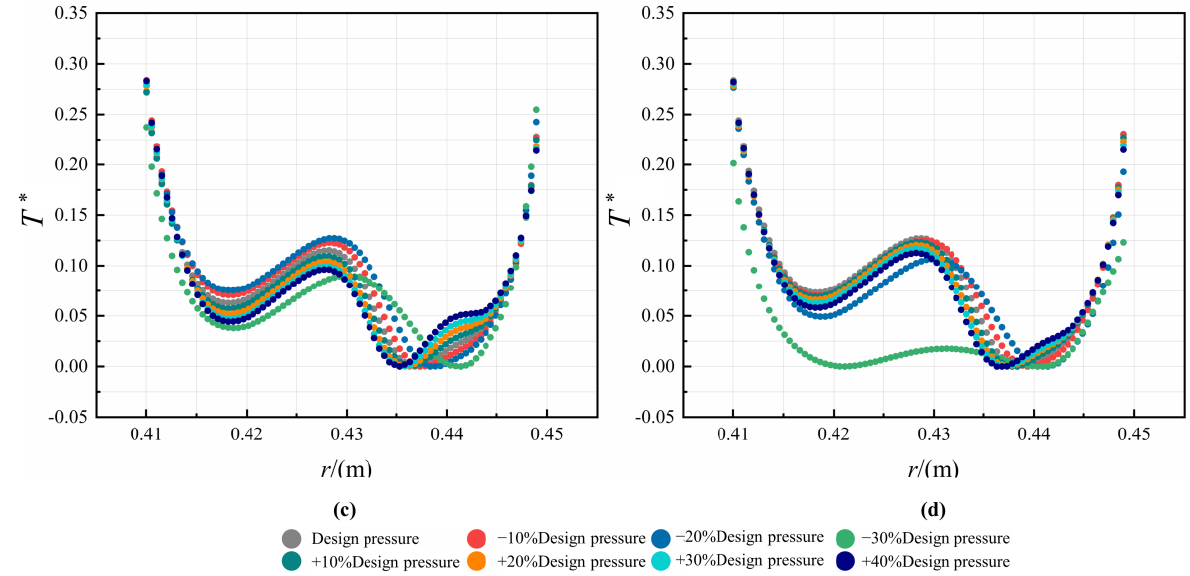
Figure 16. Radial distribution of non-dimensional temperature in C1 cavity for different Re : ( a ) Re = 2.3793 × 105, ( b ) Re = 4.7586 × 105, ( c ) Re = 7.1379 × 105, and ( d ) Re = 9.5172 × 105.